Question: Which kind of chart has been used to present this data?
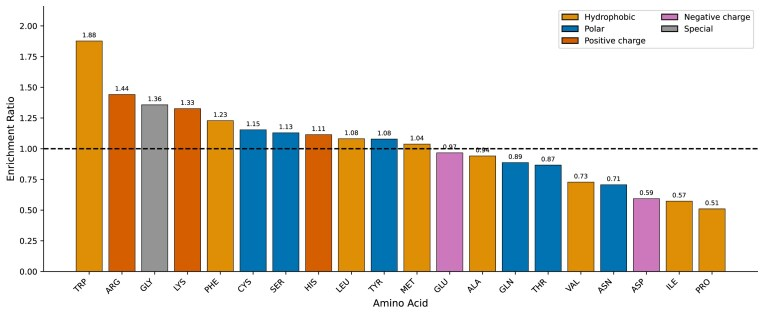
Answer: bar